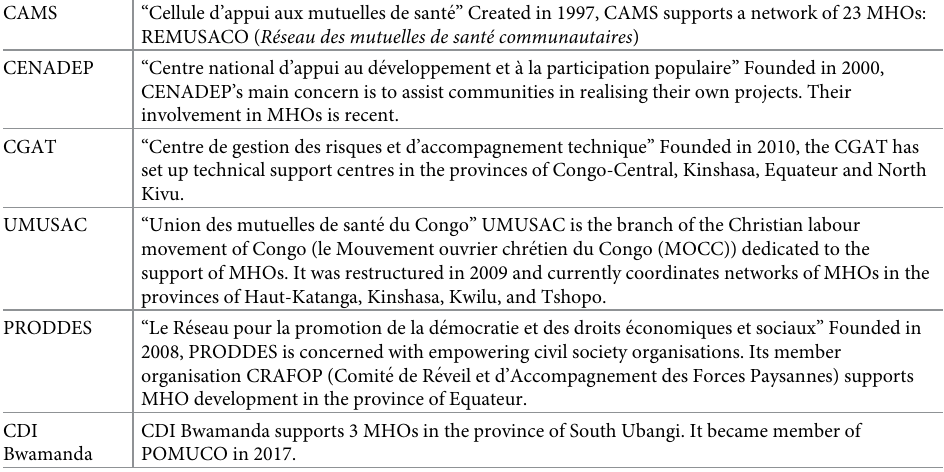
Table 1. The technical support centres forming